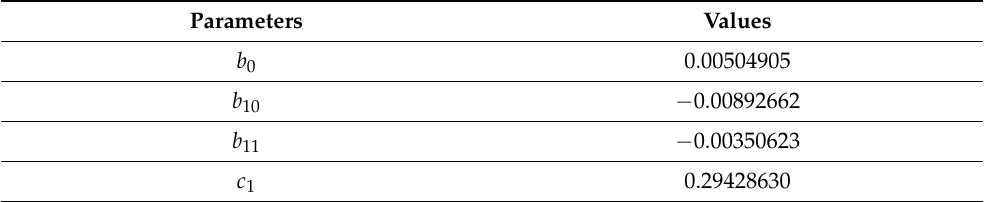
Table A2. Nelson–Siegel parameters for the ICE Euro swap rates on the